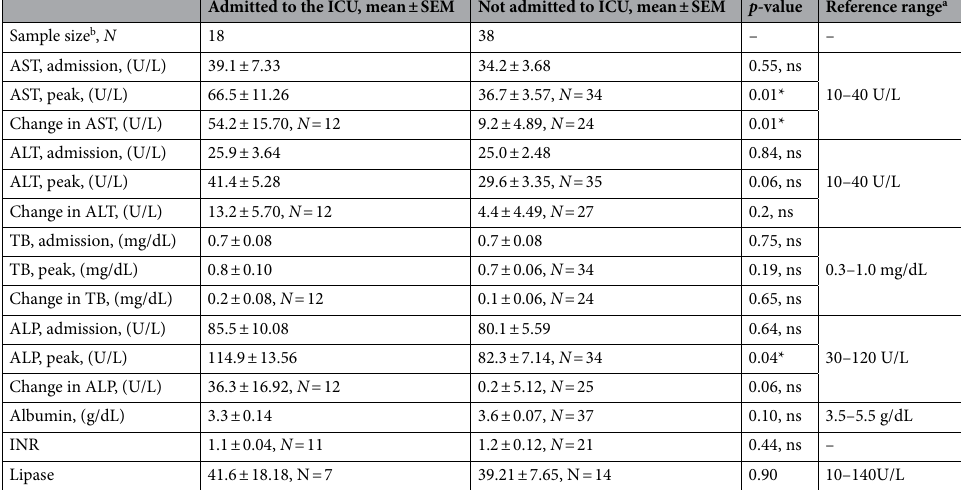
Table 3. The relationship between laboratory data collected at different time points and need for ICU admission during hospital stay. Data are presented as mean ± SEM. A Welchs two sample t-test was used to make comparisons with p < 0.05 indicating statistical significance. An * implies a significant result. Sample sizes are indicated next to data point if different from main group heading. ALT alanine aminotransferase, ALP alkaline phosphatase, AST aspartate aminotransferase, CI confidence interval, ICU intensive care unit, INR international normalized ratio, ns non-significant, SEM standard error of the mean, TB total bilirubin. a Obtained from the ABIM Laboratory Test Reference Range datasheet, https:// www. abim. org/ ~/